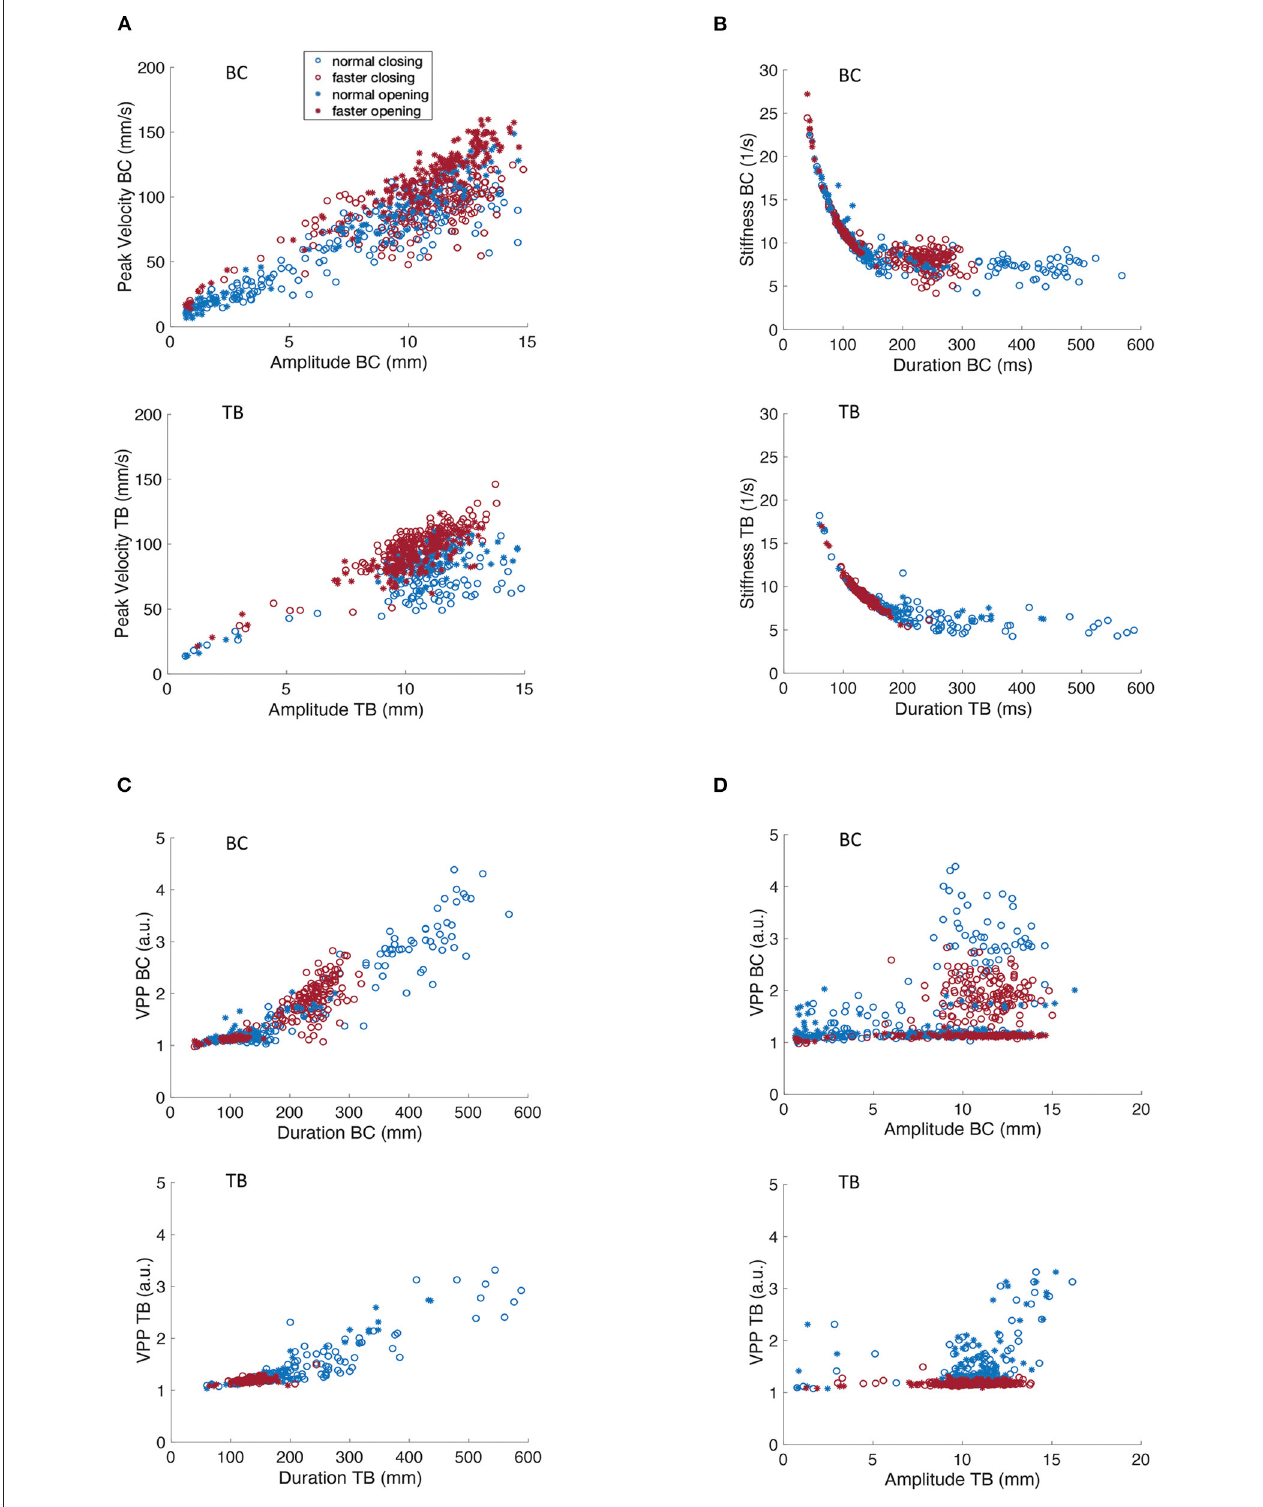
FIGURE 3 | Covariation of kinematic parameters of BC and TB gestures for participant M2 for productions of [ipa]. (A) Peak velocity vs. movement amplitude. (B) Stiffness vs. duration. (C) Velocity profile parameter vs. duration. (D) Velocity profile parameter vs. amplitude.